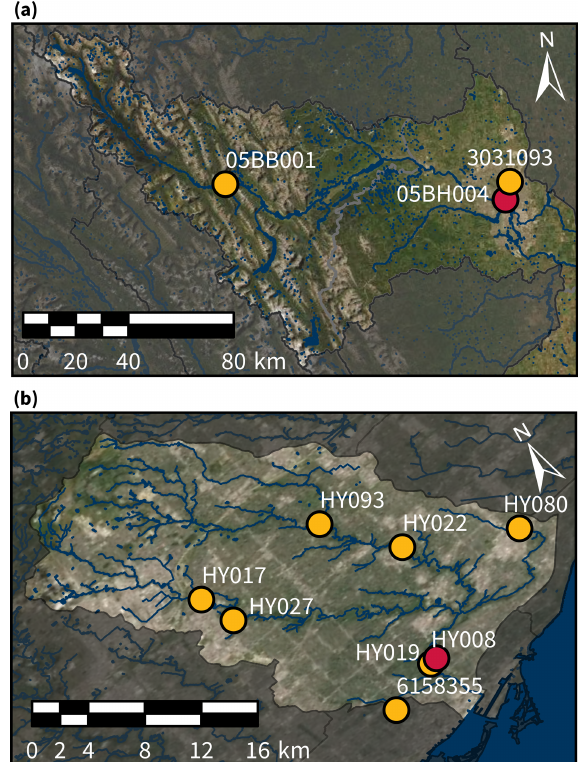
Figure 1. Bow (a) and Don (b) River basins upstream of Cal- gary and Toronto, respectively. Surface watercourses and water- bodies are shown in blue. The target stage monitoring stations are red, while upstream hydrometeorological monitoring stations (stage, precipitation, and temperature) are yellow. Aerial imagery obtained from © Esri (Esri, 2020). Surface water and watershed boundaries obtained from © Scholars GeoPortal (DMTI Spatial Inc., 2014a, b, c, 2019) and the © TRCA (Toronto and Region Con- servation Authority,